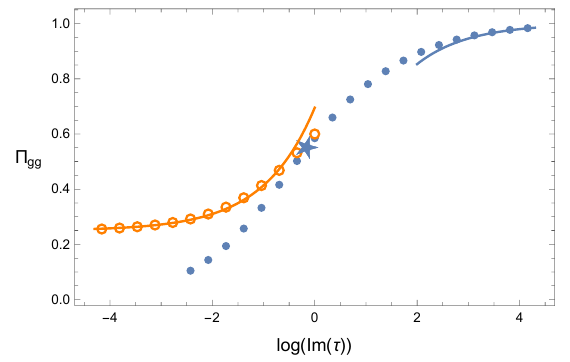
Figure 6 . A plot of (cid:5) gg vs. Im (cid:28) for the n + = 1, n (cid:0) = 0 theory. We set Re (cid:28) = 0. The solid points and the star have Re (cid:28) = 0 while the open orange circles have Re (cid:28) = 1 = 2. The star is the self-dual point. The curves are saddle point